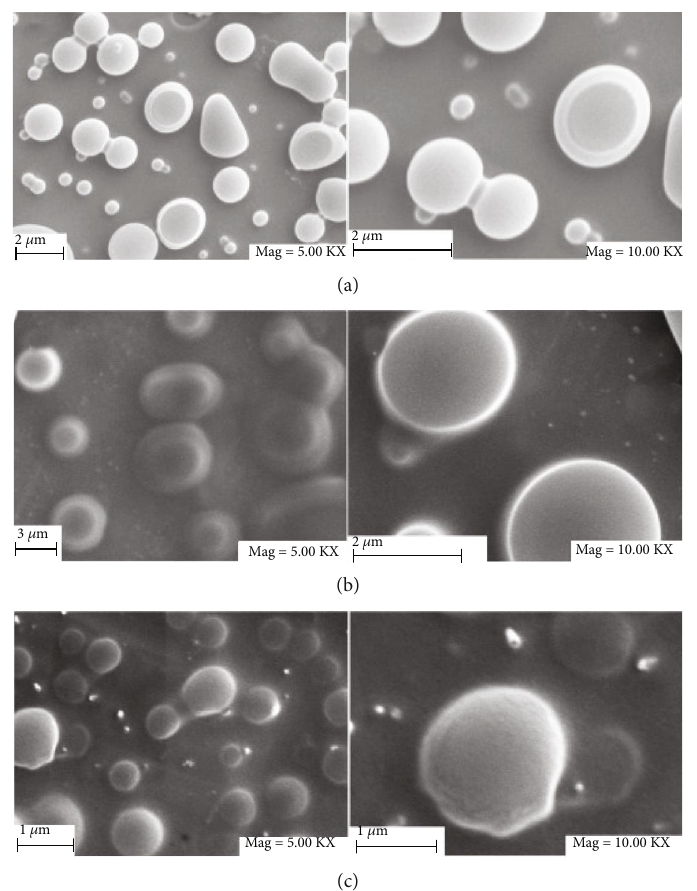
Figure 53: Morphology and size of the PU microcapsules synthesized using (a) 1,4-butanediol, (b) 1,6-hexanediol, and (c) glycerol